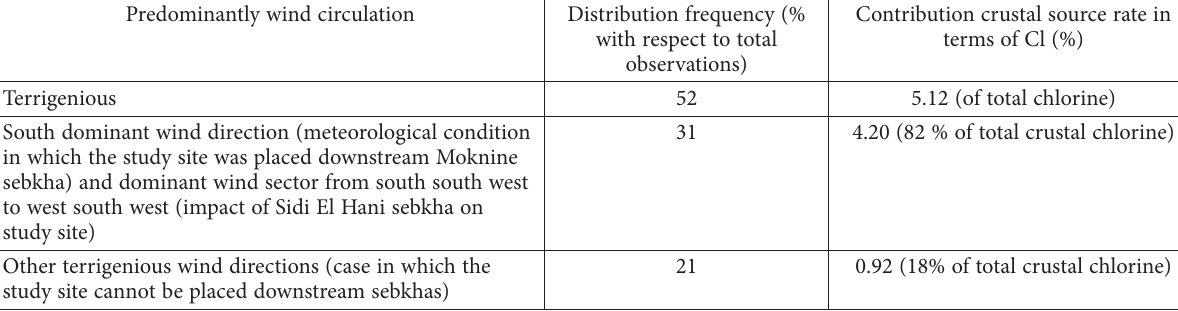
Table 9. Estimated crustal source contribution rate in terms of chlorine (S23) Predominantly wind